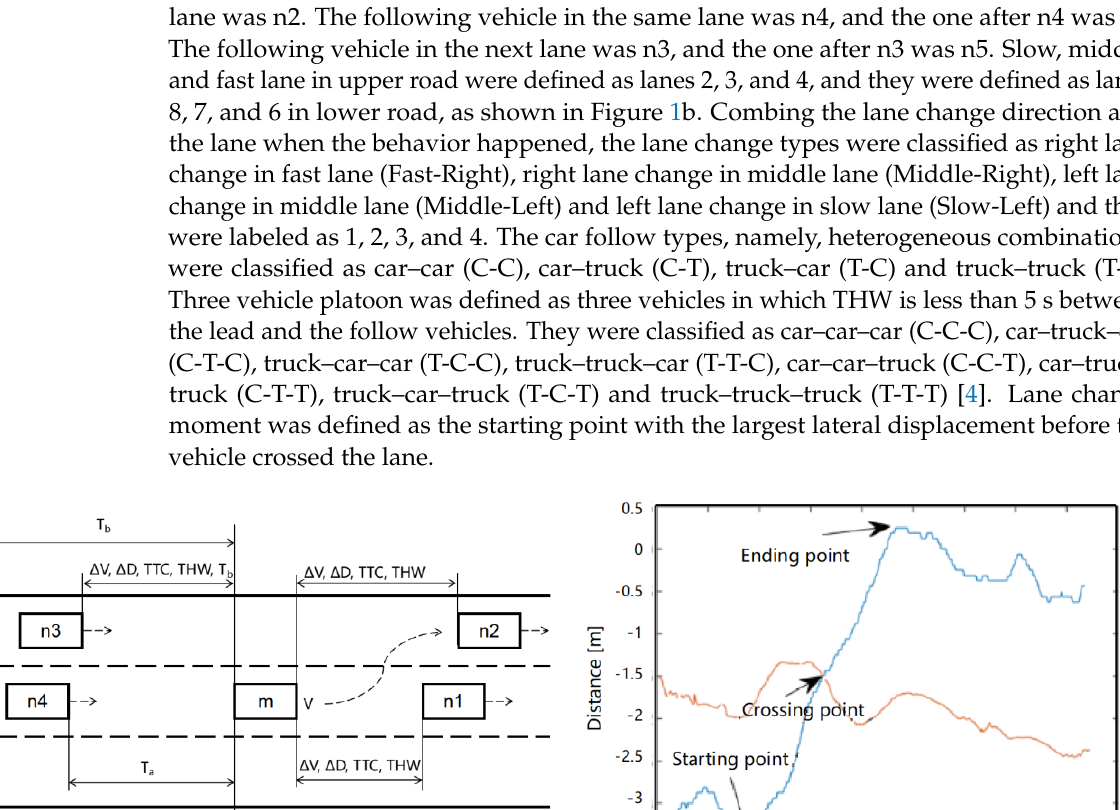
Figure 2. Lane change ( a ) participant definition and ( b ) moment definition.